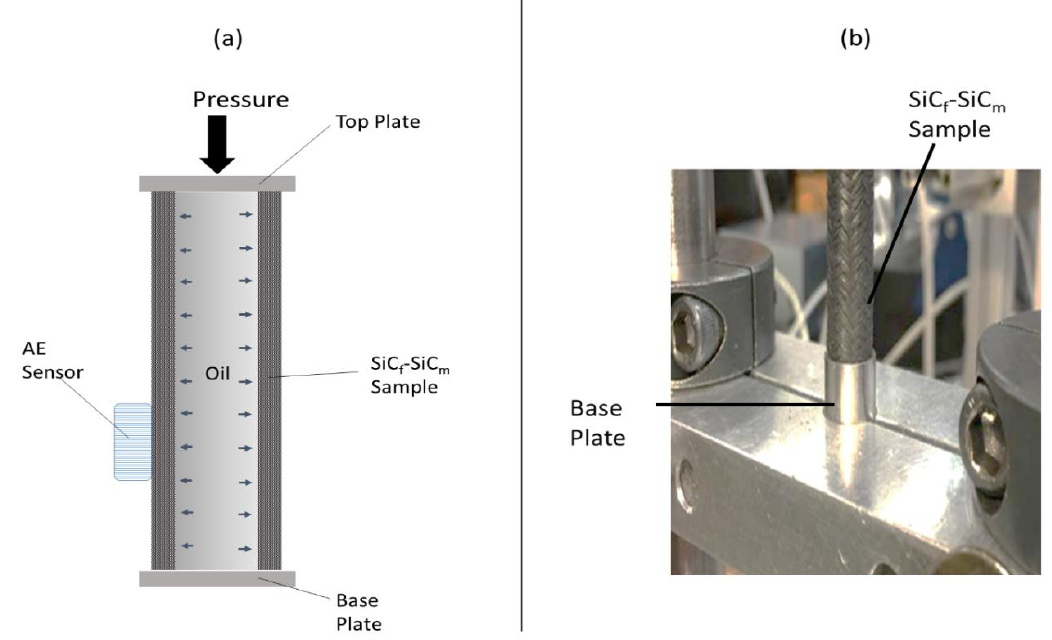
Figure 1. Open end burst test setting on the SiC f -SiC m tubes. ( a ) Schema of the setting for the burst test. ( b ) Real experimental setup of the burst test.